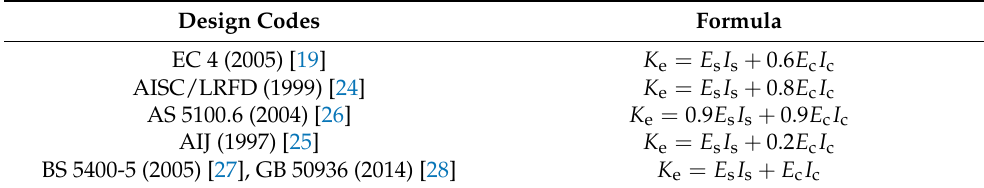
Table 6. Flexural stiffness formulas of the design codes for